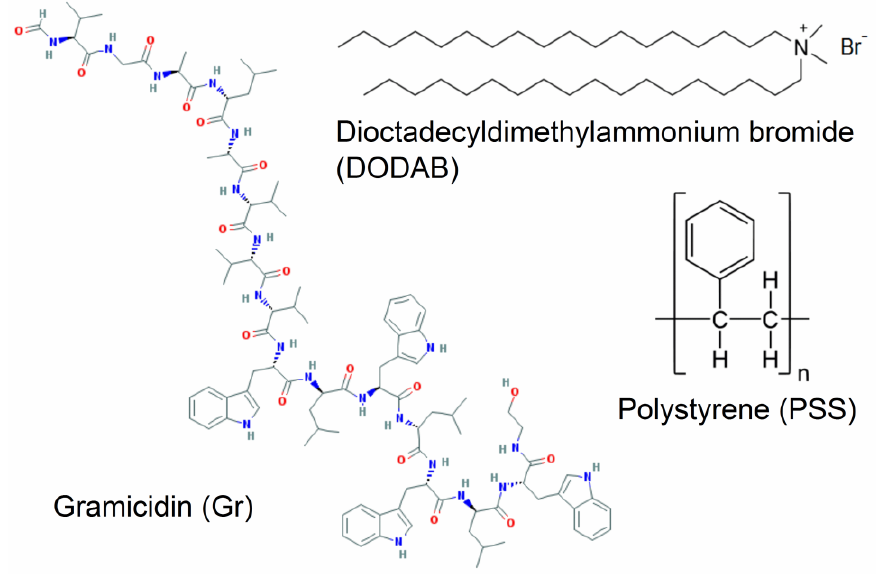
Figure 1. Chemical structure of the antimicrobial peptide Gr, the antimicrobial lipid DODAB, and the polymer polystyrene sulfate (PSS) used to build the cationic biomimetic NPs evaluated in this work regarding their antimicrobial properties. The industrial process for obtaining PSS employs potassium peroxydisulfate (KPS) as initiator for the polymerization of styrene. In water solution, KPS